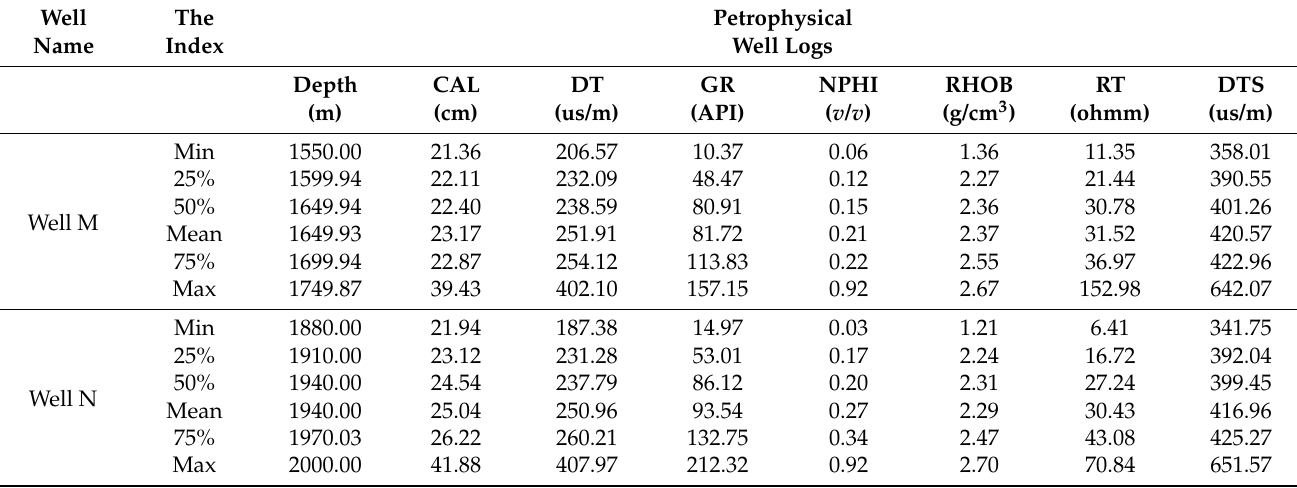
Table 1. Statistical characteristics of Well M and Well N.